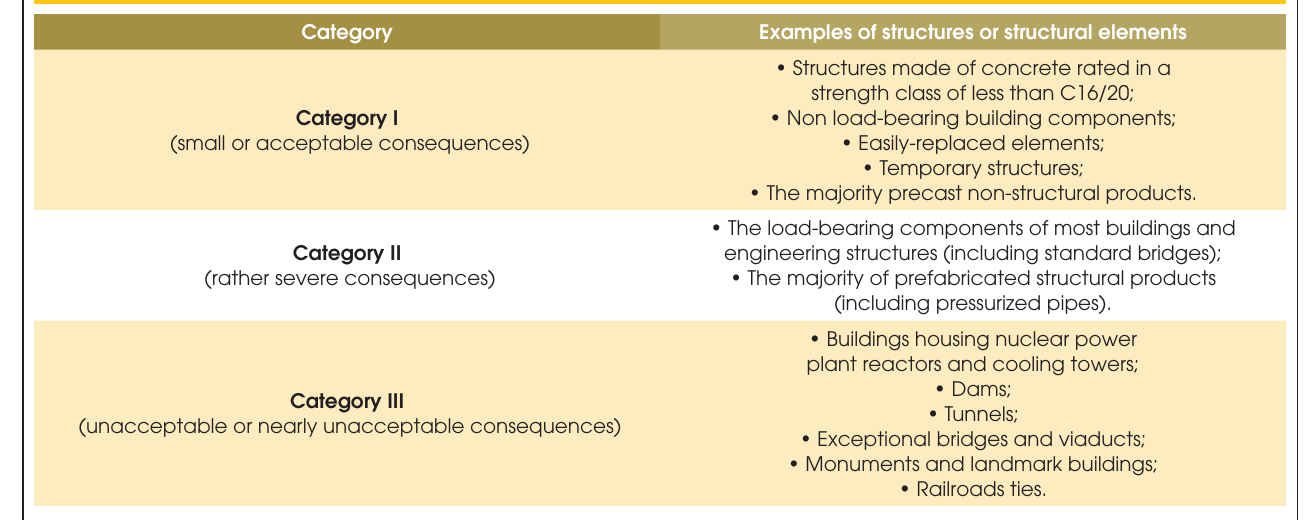
Table 1 – Examples of structures or structural elements classified by category